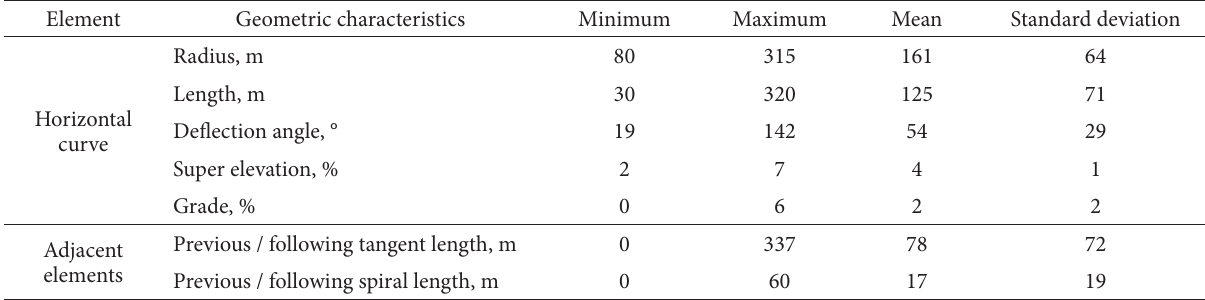
Table 1. Geometric features of the analyzed curves Element Geometric characteristics